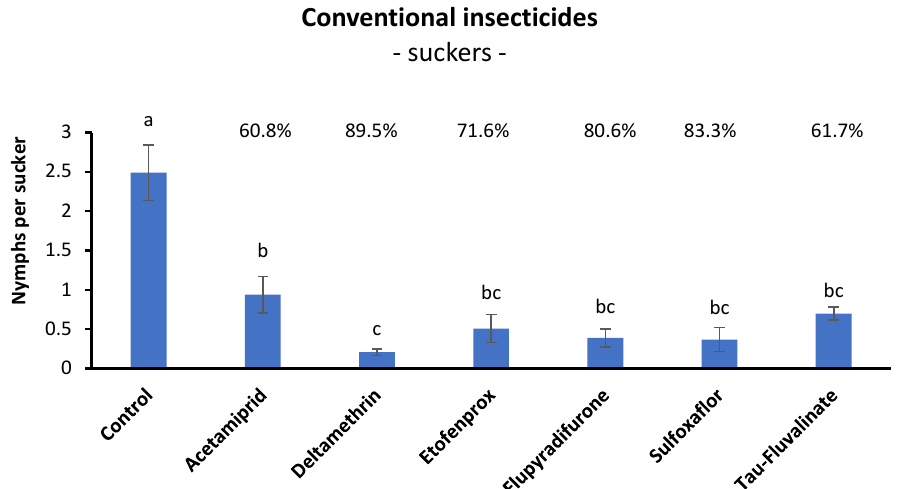
Figure 1. Effects of six insecticides on S. titanus nymphs (mean ± SE) evaluated at seven days from their application (SPF and FM vineyard). Different letters indicate significant differences at the t -test ( α = 0.05). For each insecticide the Henderson and Tilton efficacy (%) is also reported.